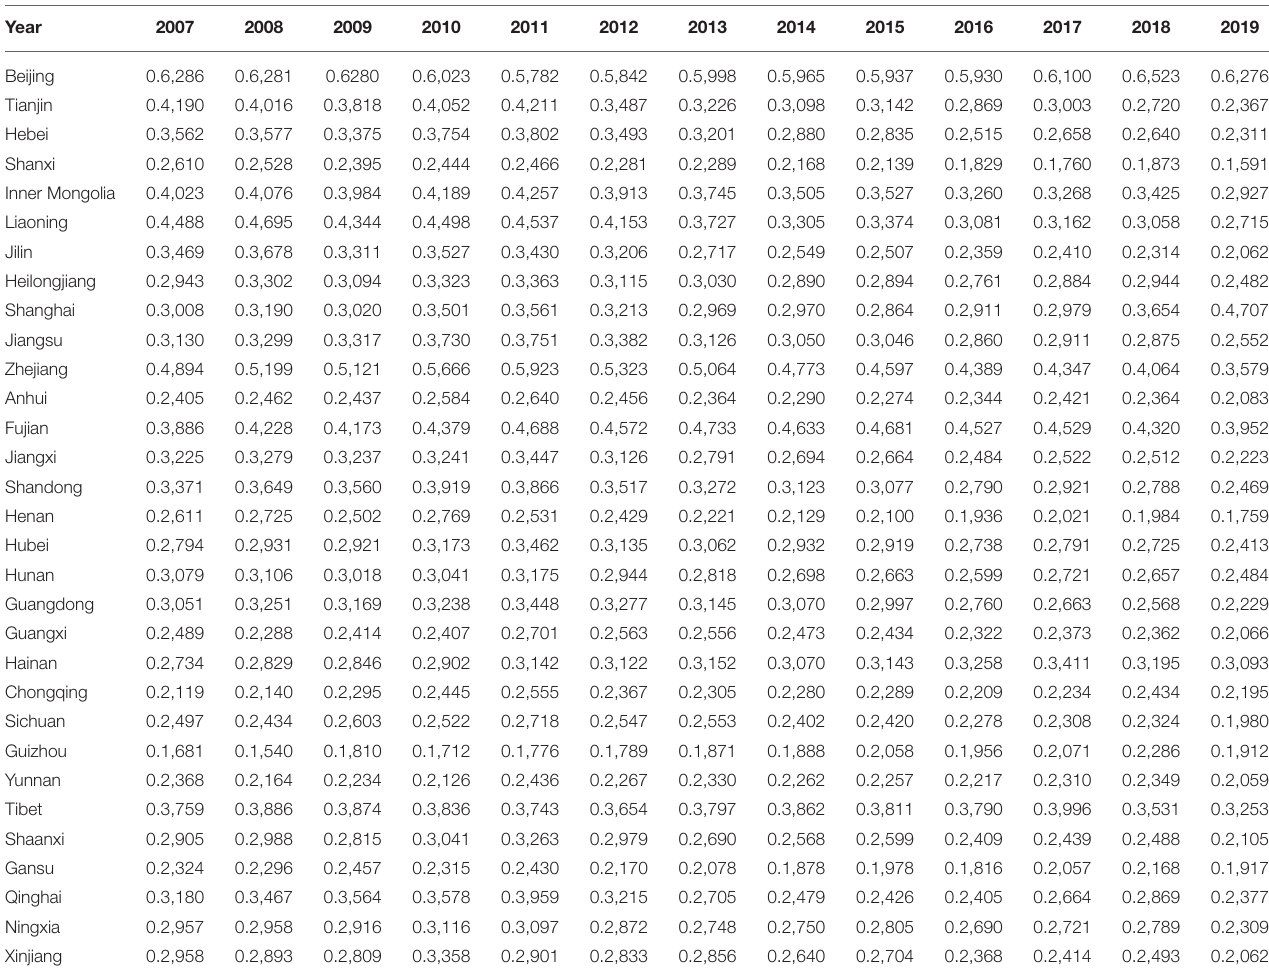
TABLE 3 | The score of agricultural green development index of 31 provinces in China from 2007 to 2019.